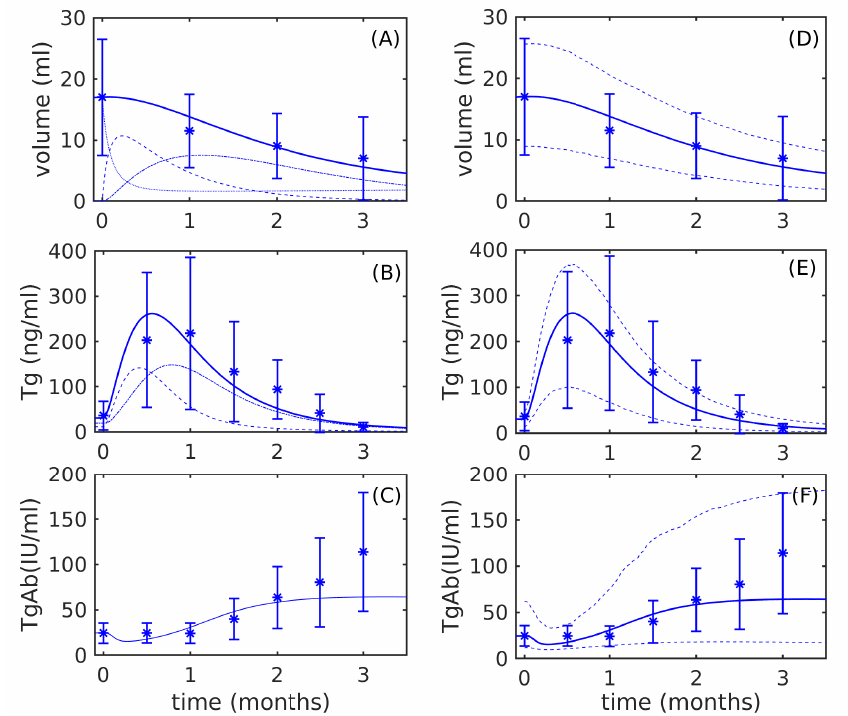
Figure 3. Evolution of population-averaged thyroid markers with time after 131 I treatment for Graves’ disease. Experimental measurements, asterisks with standard deviation error bars, and best fits obtained with the model presented in this work: ( A ) thyroid volume: total, thick solid line; and volumes corresponding to undamaged cells, dot line; doomed cells, dashed line; and dead cells, dash-dot line. ( B ) Tg concentration: total, solid line; free Tg compartment, dashed line; and bound Tg compartment, dash-dot line. ( C ) TgAb concentration. Panels ( D – F ) show 68% confidence intervals for thyroid volume, Tg, and TgAb, respectively (dashed lines), as well as population-averaged fits. In order to simulate a population, best-fitting parameters to the population-averaged data were perturbed with normal distribution with 25% relative standard deviation (1000 different sets of parameter values to simulate a population of 1000